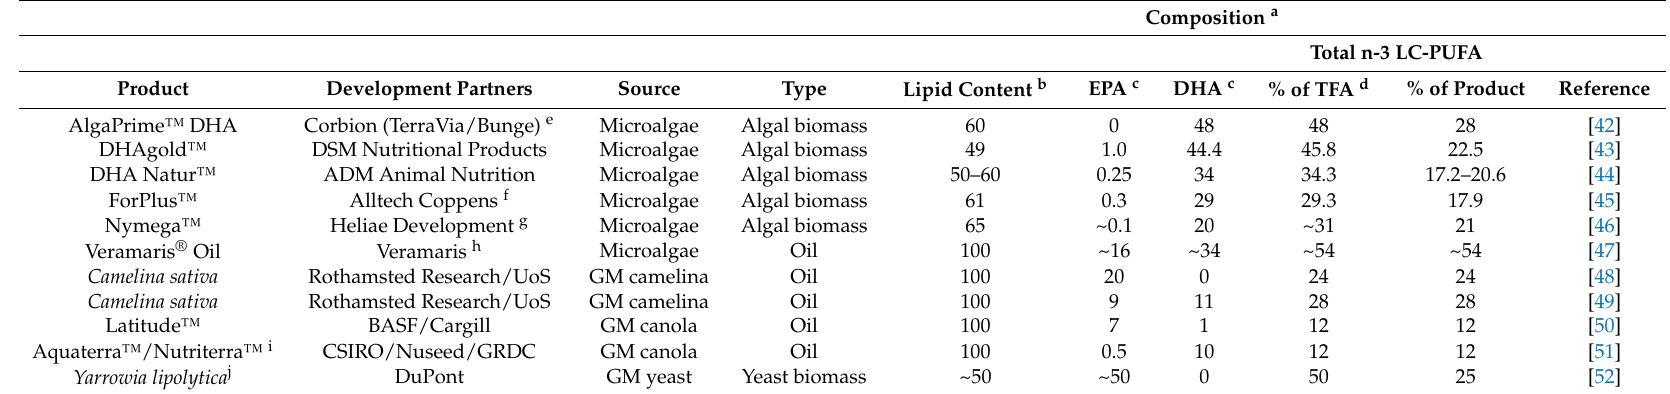
Table 1. Summary of the origins and compositions of some potential new sources of EPA and